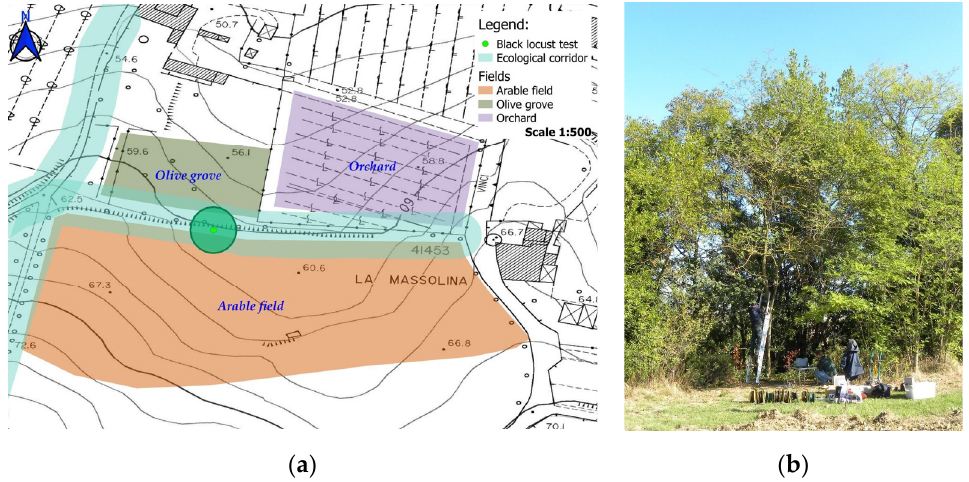
Figure 1. An overview of the selected site ( a ) and the tree during the installation of the accelerometers ( b ).